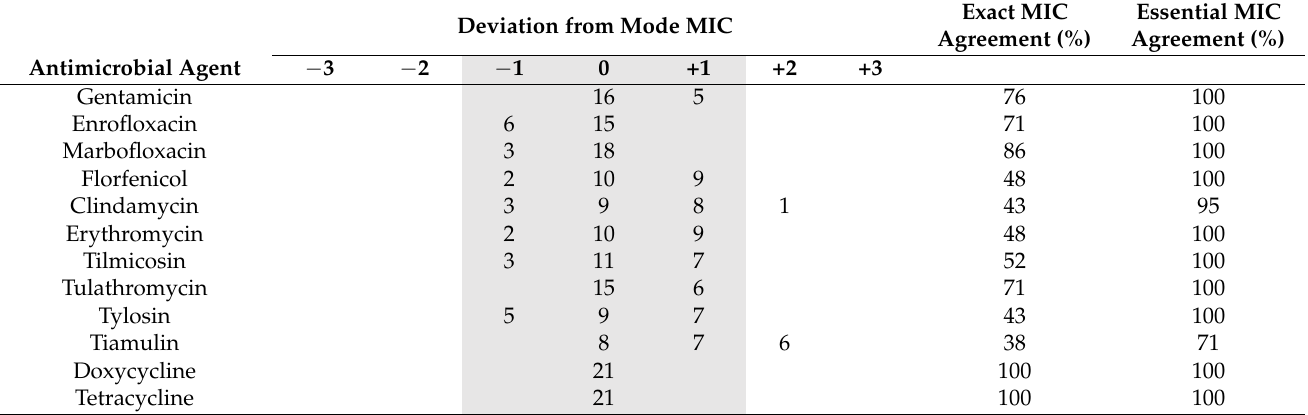
Table 5. Homogeneity of the MIC values of 21 test replicates of M. hyorhinis DSM 25591 tested in modified Friis broth, prepared with different batches of ingredients. The mode MIC and its deviations were determined based on the results of the initial testing of M. hyorhinis DSM 25591 (see Table 2). The grey shaded area contains the MIC values accounting for the essential MIC